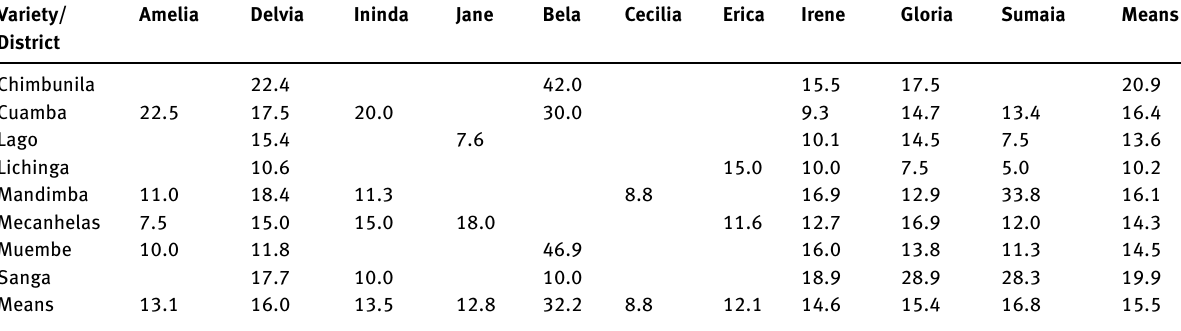
Table 4: Yield in t/ha of different varieties at different districts